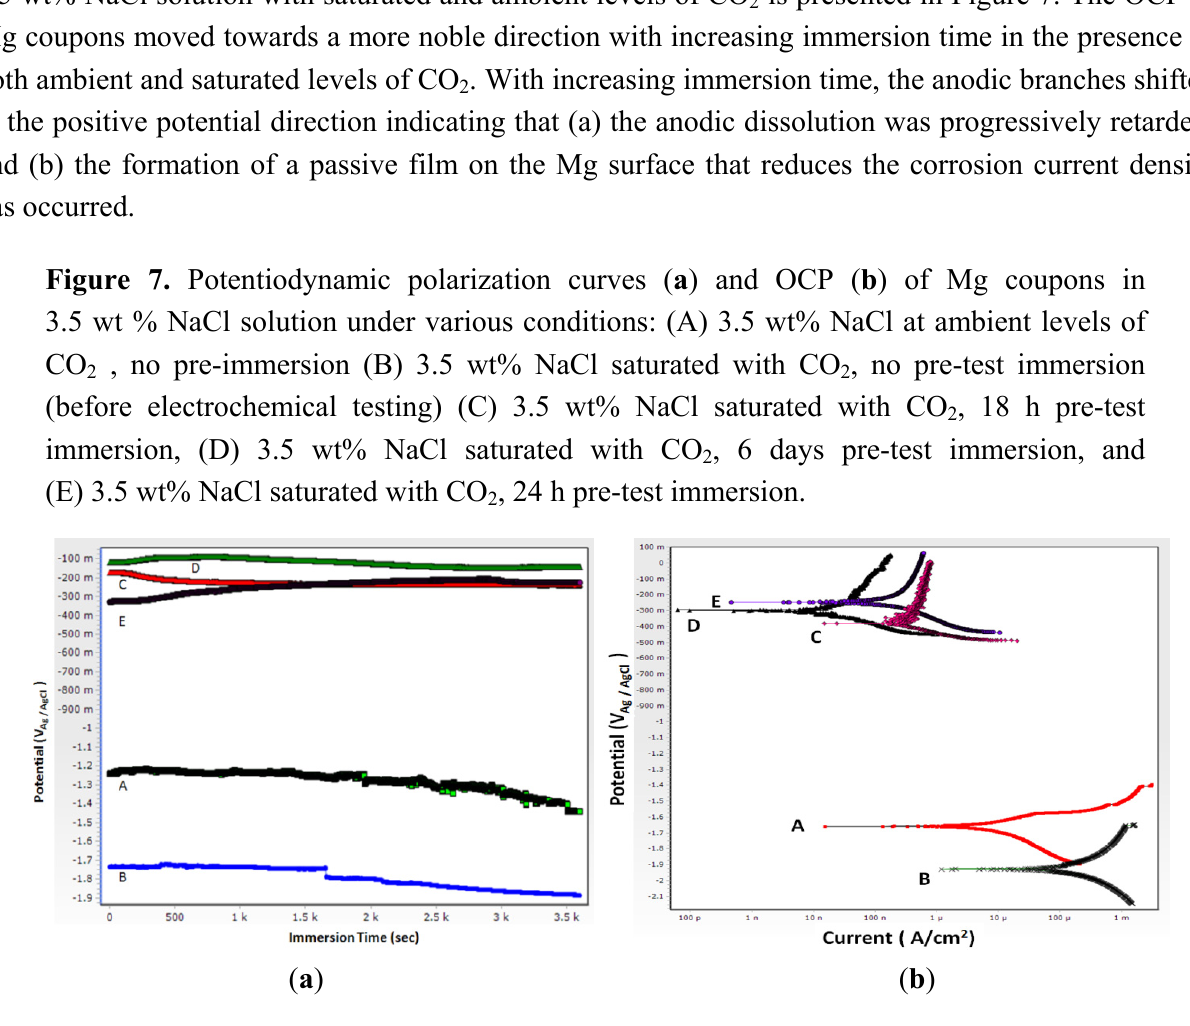
Figure 7. Potentiodynamic polarization curves ( a ) and OCP ( b ) of Mg coupons in 3.5 wt % NaCl solution under various conditions: (A) 3.5 wt% NaCl at ambient levels of CO , no pre-immersion (B) 3.5 wt% NaCl saturated with CO 2 (before electrochemical testing) (C) 3.5 wt% NaCl saturated with CO immersion, (D) 3.5 wt% NaCl saturated with CO